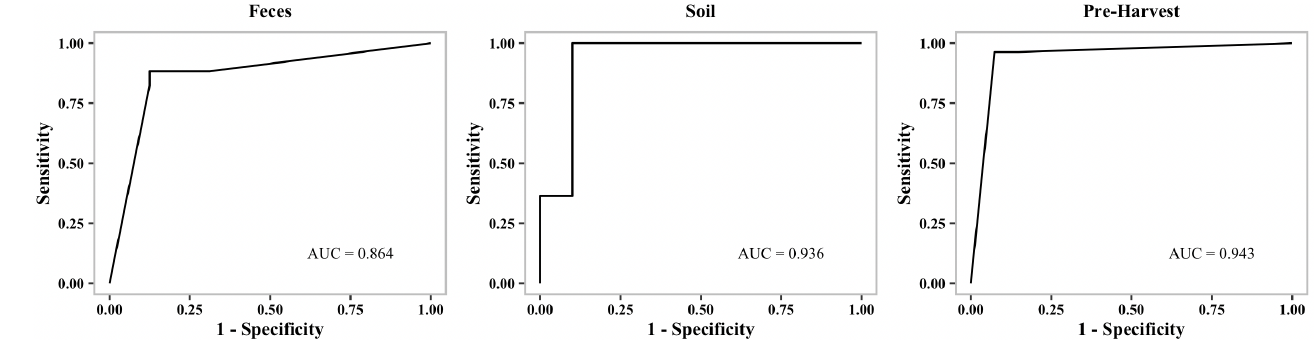
Figure 1. Receiver operating characteristic curve (ROC curve) of Salmonella MDR